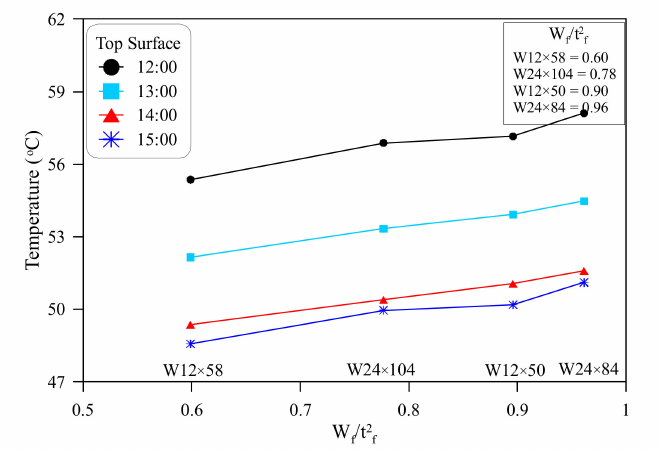
Figure 9. Relationship between top surface temperature and W f / t f 2 at noon